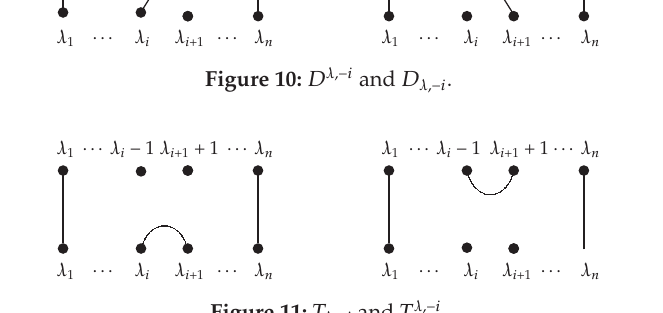
Figure 11: T λ, − i and T λ, − i